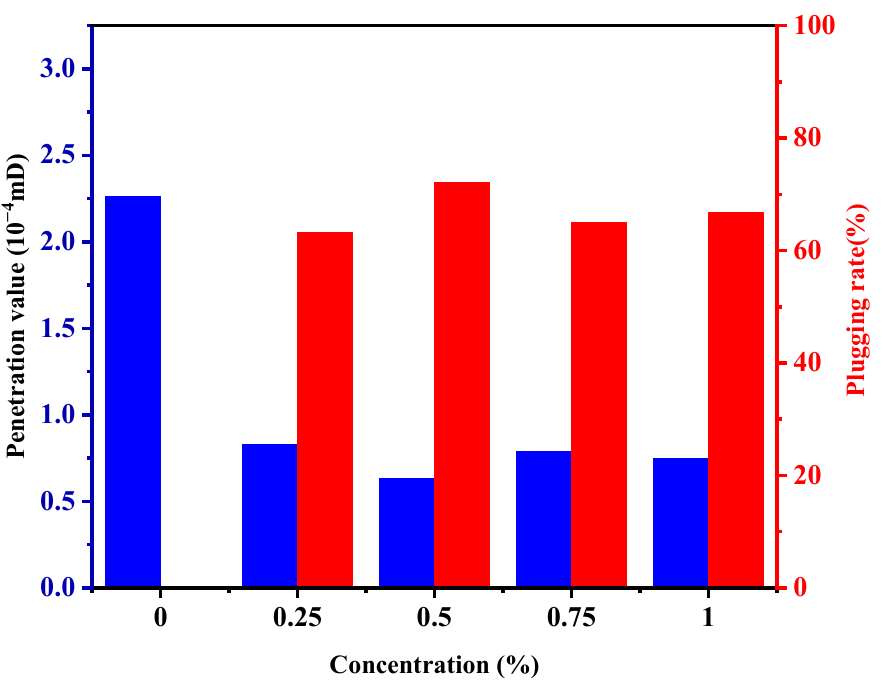
Figure 8. Variation of permeability and plugging rate for different doses of poly (MMA-BA-ST).